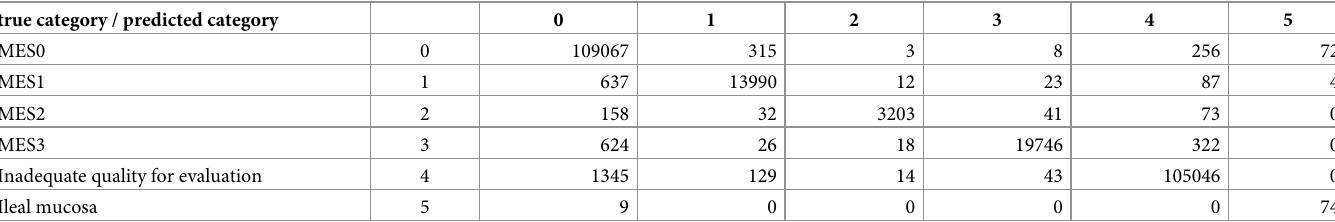
Table 4. Confused matrix showing the classification results using established convolutional learning network. true category / predicted category